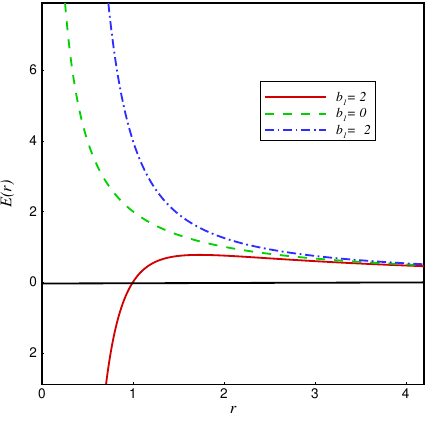
Figure 3 . The behavior of the electric field F tr = E ( r ) for 3D charged mimetic black holes with q = 2